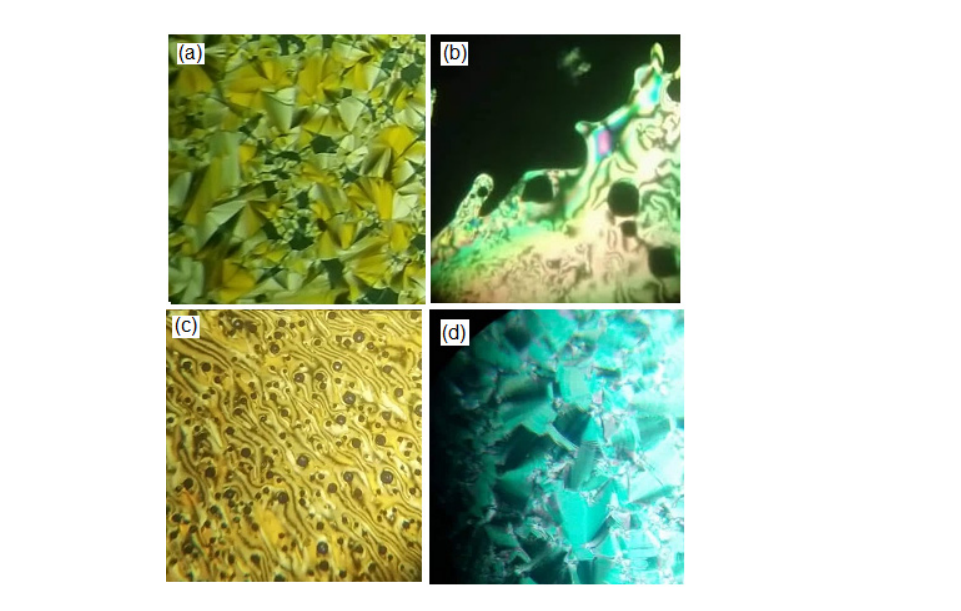
Figure 2. POM textures via heating of ( a ) SmA phase at 102 °C for T14 derivative; ( b ) N phase at 150 °C for T14 derivative; ( c ) N phase at 130 °C for T6 derivative and ( d ) SmA phase at 110 °C for T16 derivative.